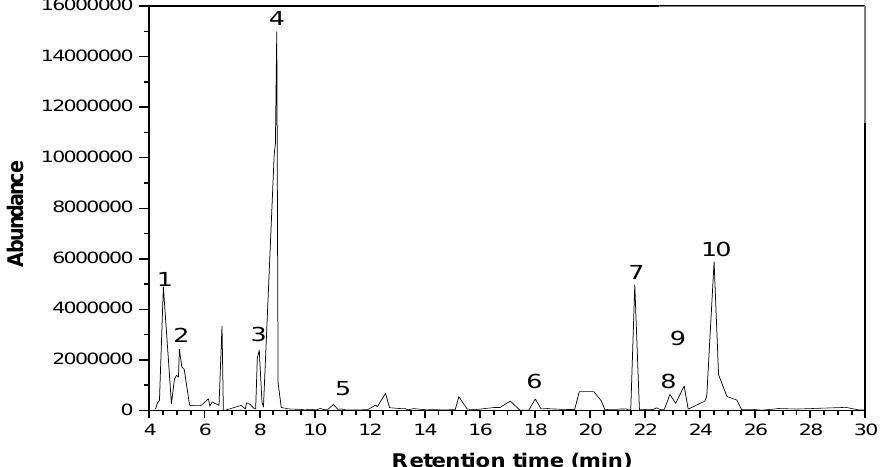
Figure 1. Chromatogram of mango peel extracts. (1) Pyrogallol (R.T., 4.51); (2) Melezitose (R.T., 5.08); (3) Succinic acid (R.T., 7.86); (4) Linolelaidic acid (R.T., 8.53); (5) Vitamin A (Retinyl palmitate) (R.T., 10.97); (6) γ − tocopherol (R.T., 20.41); (7) Vitamin E (R.T., 21.63); (8) Campesterol (R.T., 22.91); (9) Stigmasterol (R.T., 23.42); (10), γ − sitosterol (R.T., 24.51).